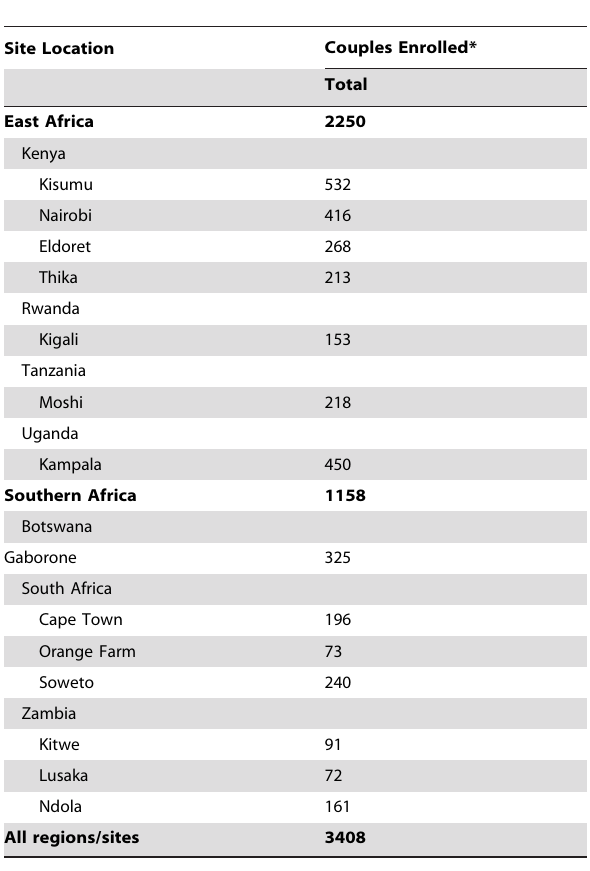
Table 2. Sites and total enrollment for Partners in Prevention HSV-2/HIV-1 Transmission Study (Partners